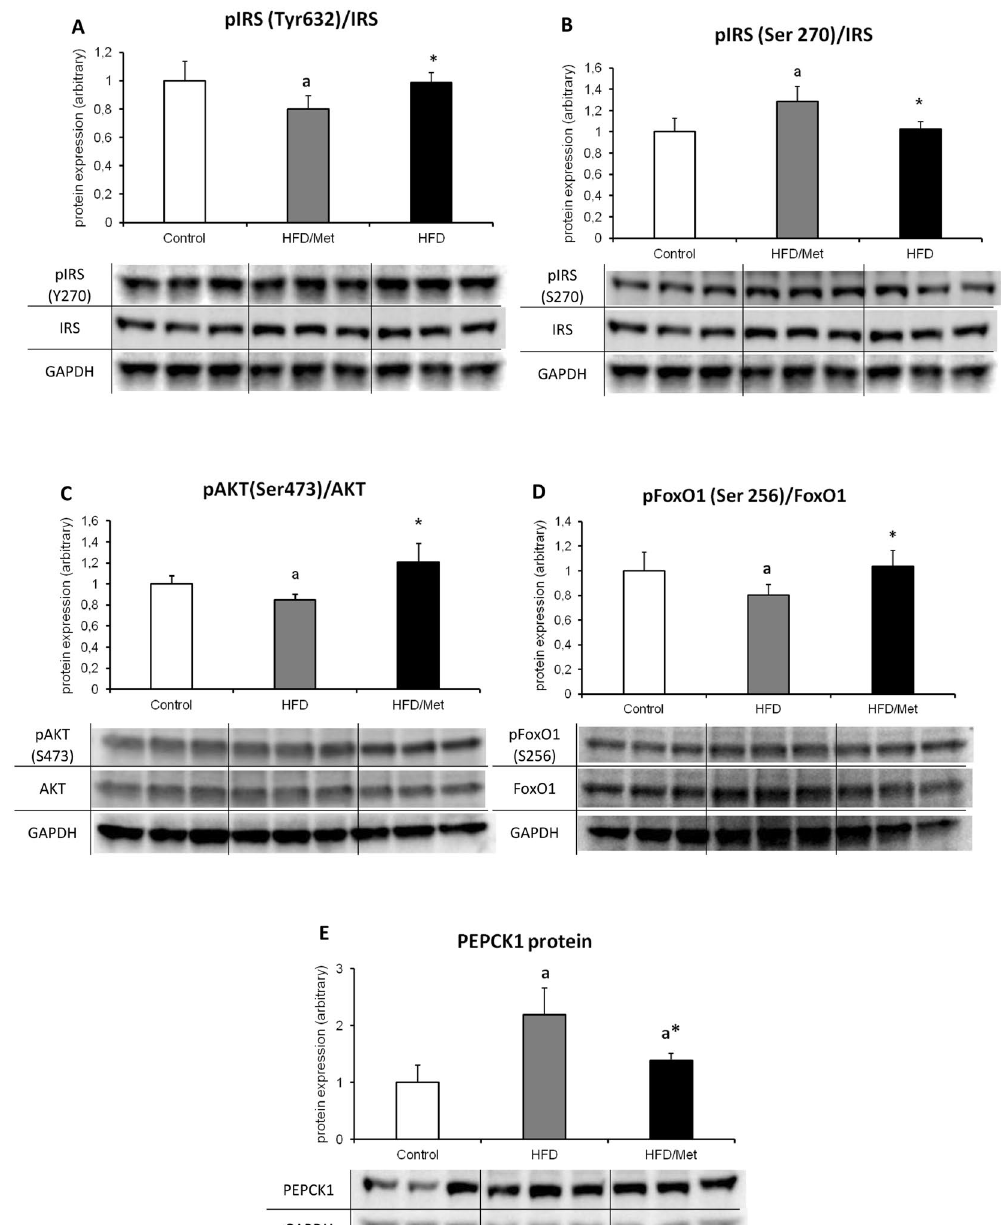
Figure 5. Metformin treatment of HFD animals improves hepatic insulin signaling. The figure present activatory (Tyr632, Panel A) and inhibitory (Ser270, Panel B) phosphorylation state of insulin receptor substrate 1 (IRS1); Panel C presents a ratio phosphorylation state of Akt at Ser473 and panel D shows a FoxO1 phosphorylation state at Ser256; The impact of HFD and metformin treatment on protein content of PEPCK1 is presented in Panel E. Values are mean + / − SD. Symbols denote statistical significance of p < 0.05 versus: a- vs. Control group; * - vs. HFD group. n = 8 per group; Significance by Anova with Tukey HSD post-hoc